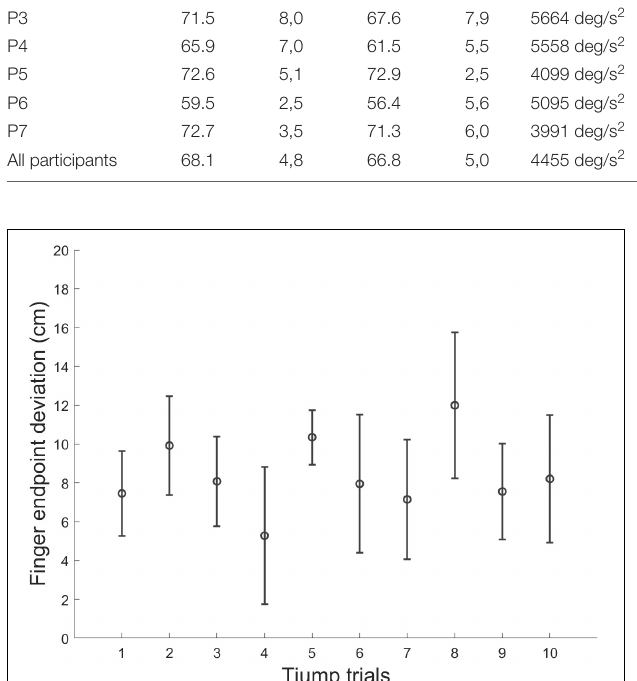
FIGURE 6 | Mean finger endpoint deviations in each T jump trial along the experimental session in microgravity. Errors bars represent between-subject standard